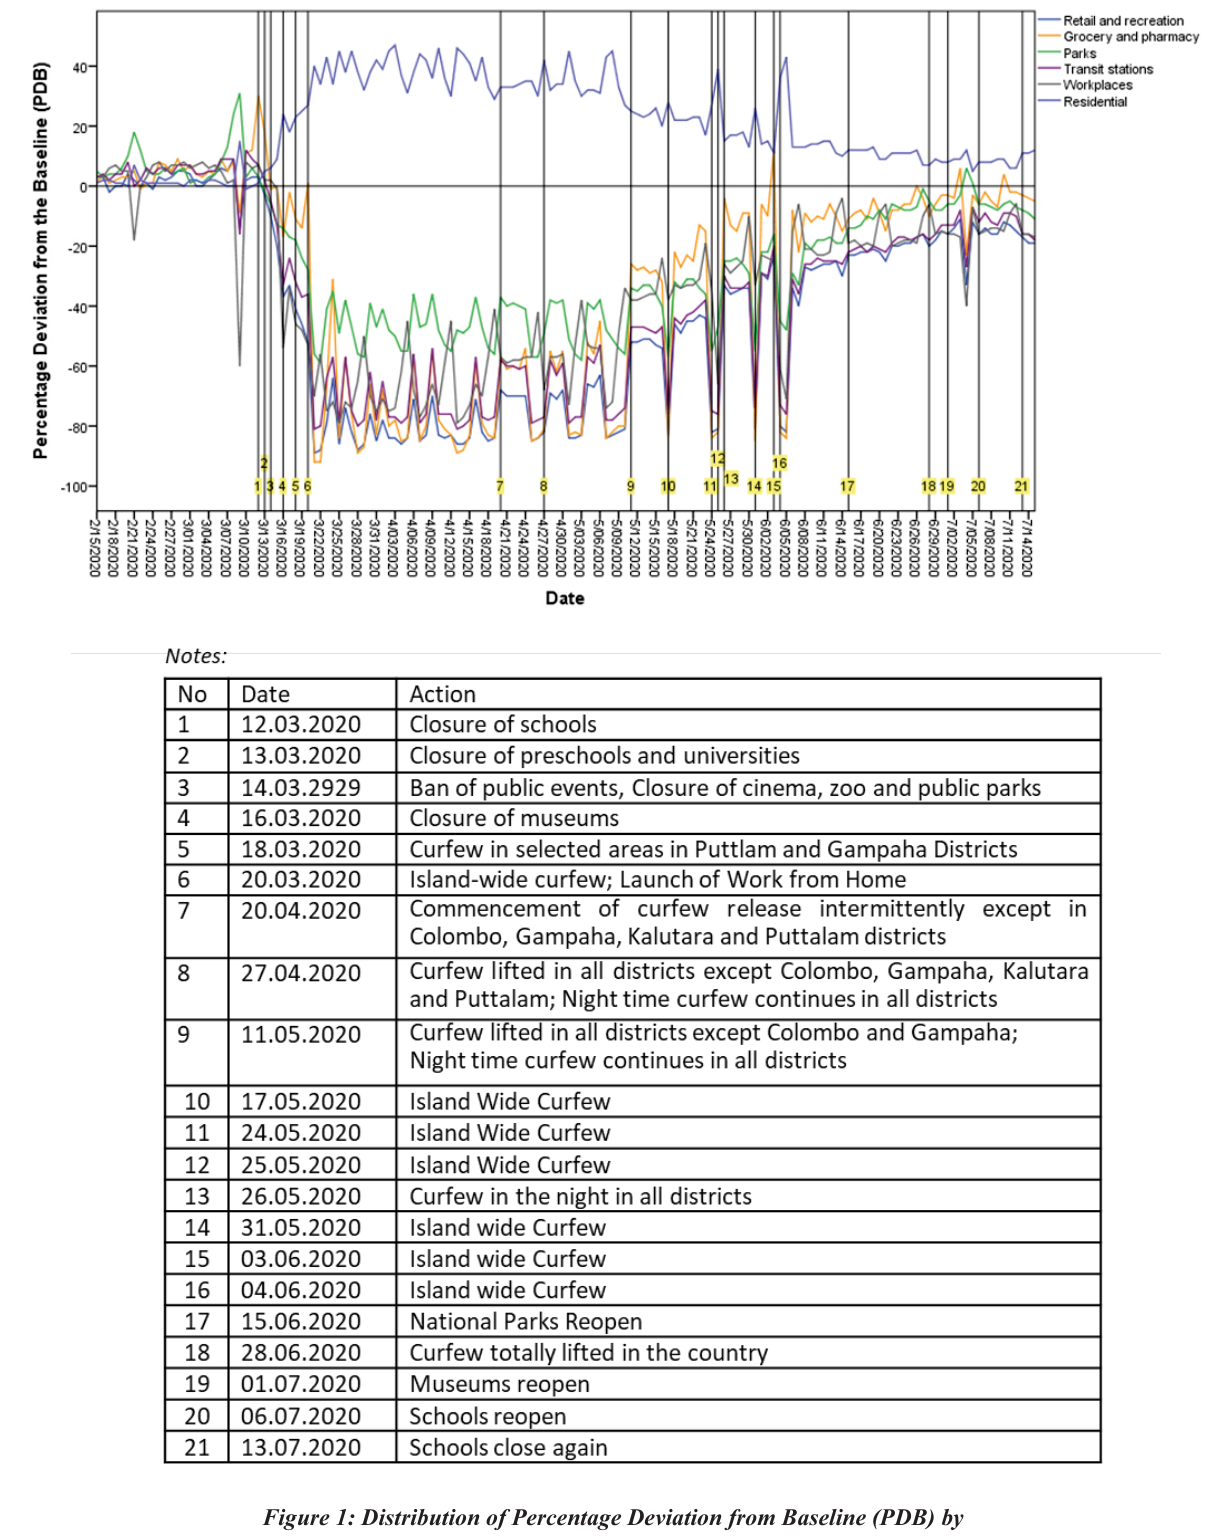
Figure 1: Distribution of Percentage Deviation from Baseline (PDB) by Location Categories and Public Health